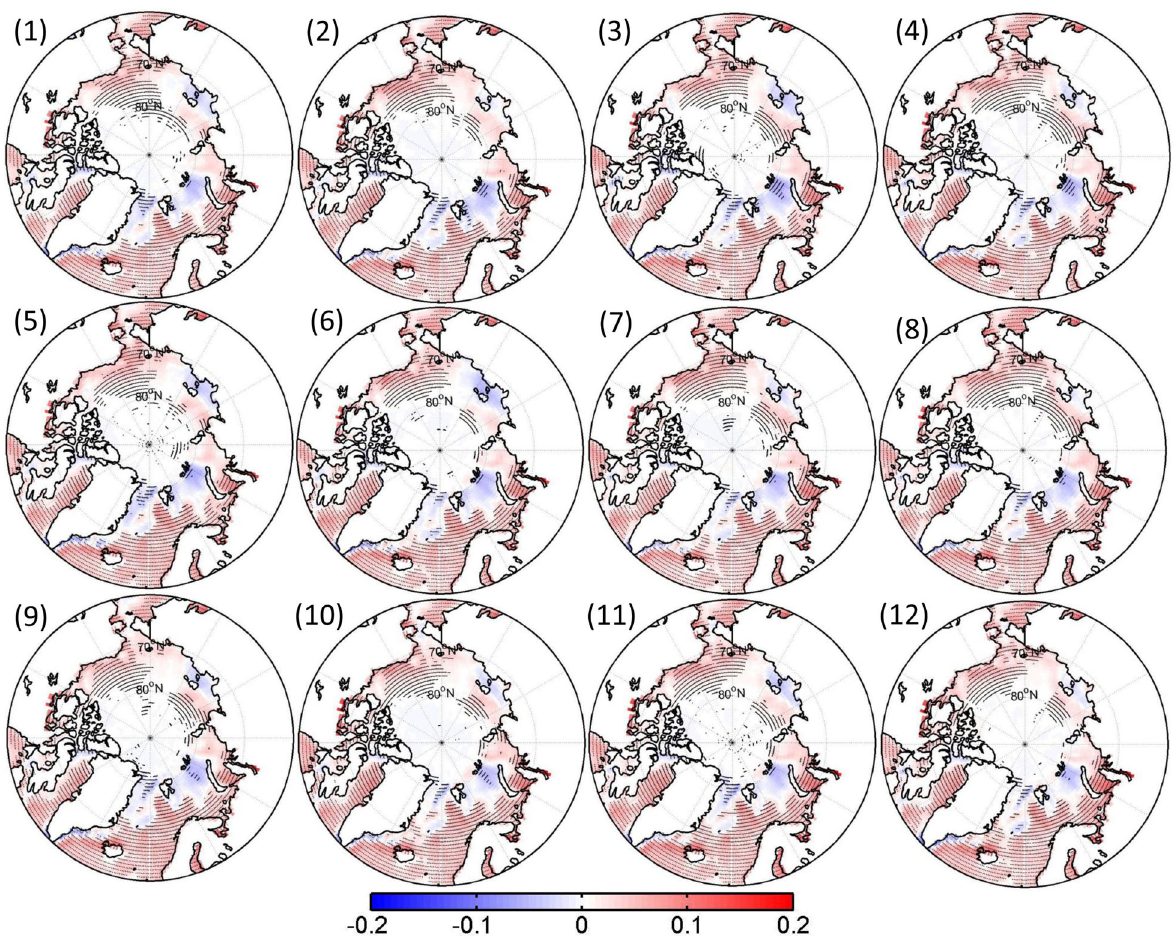
Fig. 14 Trend in sea surface temperature (SST) for each node (unit: °C yr − 1